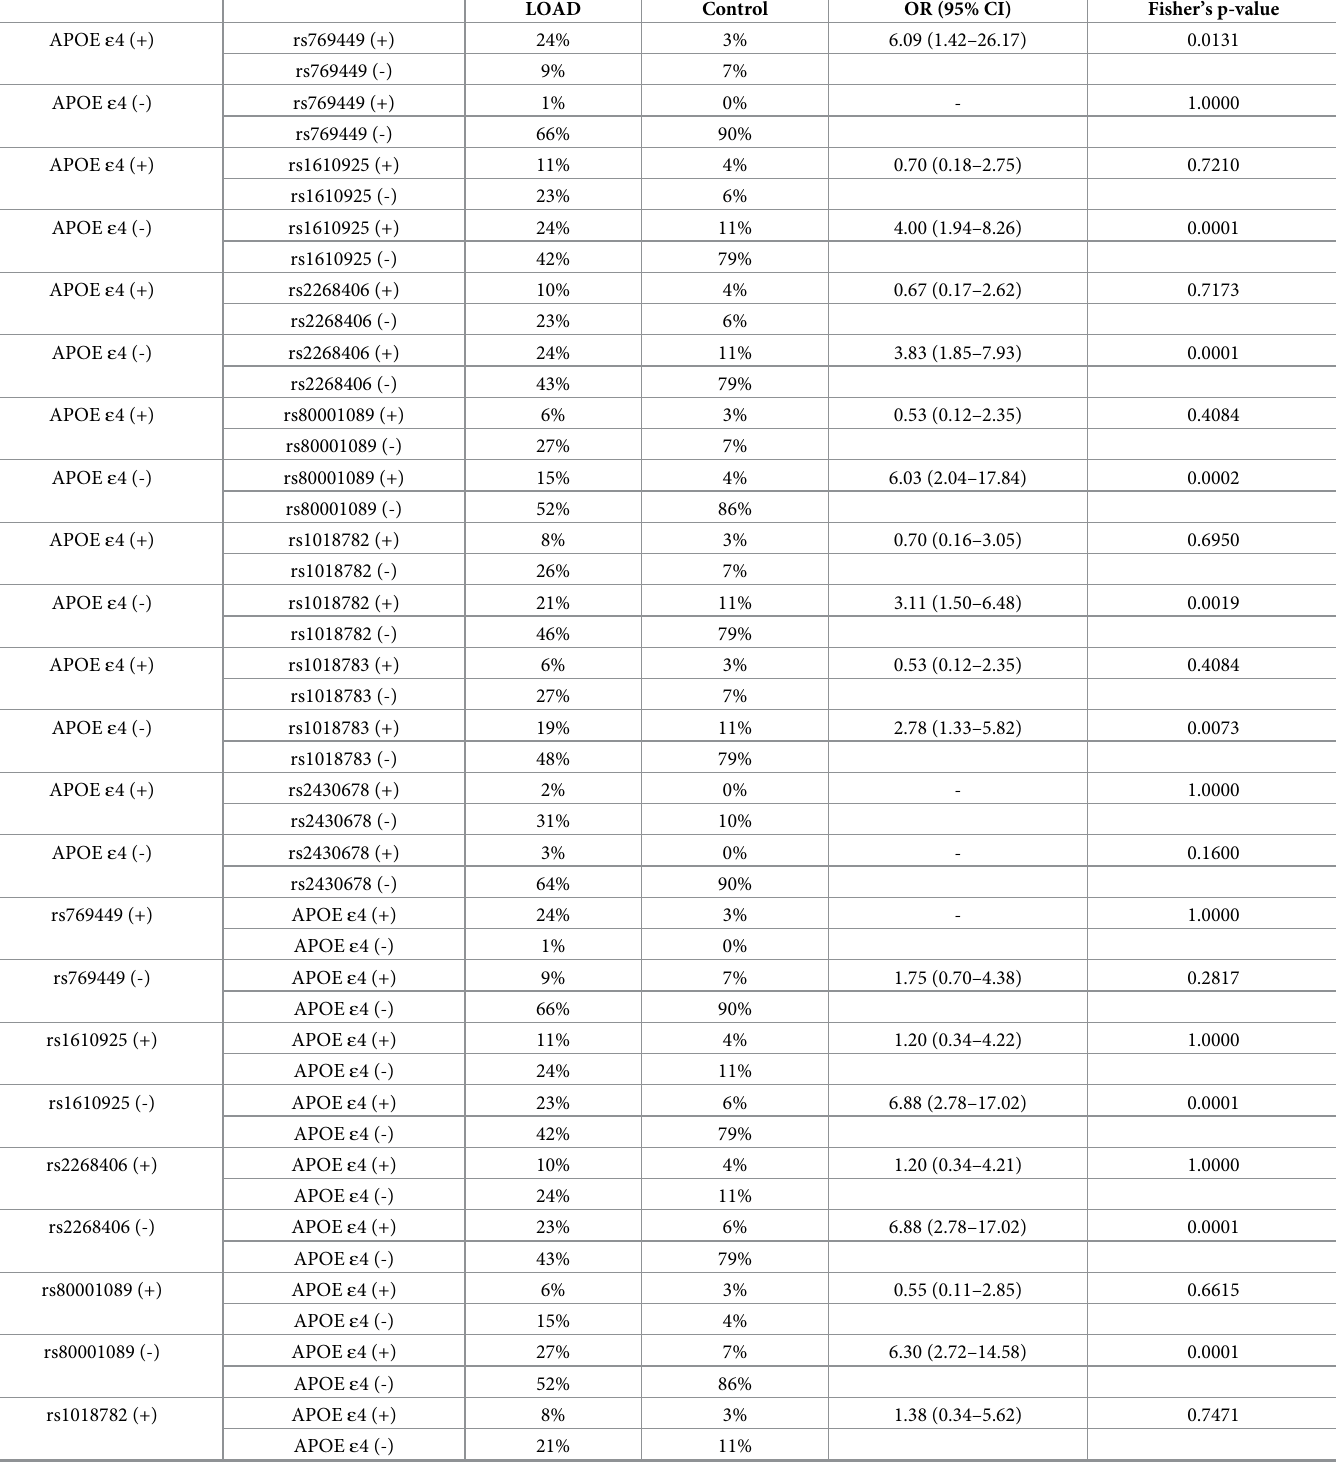
Table 7. Effect of the interaction of UNG and APOE variants with APOE ε 4 in blood samples of LOAD case-control